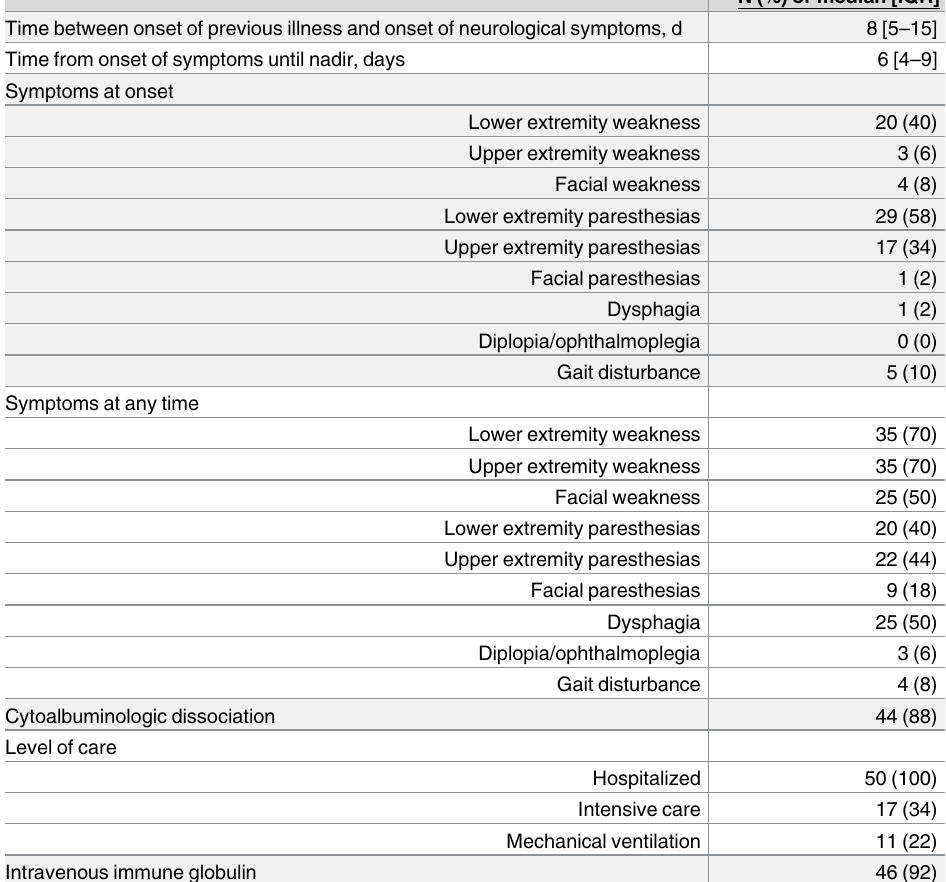
Table 2. Clinical characteristics of case-patients with Guillain-Barre´ syndrome (N = 50) in the Salva- dor metropolitan area—Brazil,